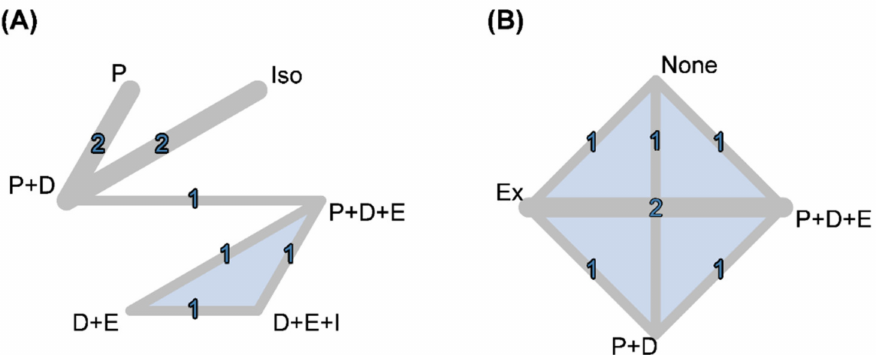
Figure 2. Network graphs of ( A ) main functional outcome (changes in hand grip) and ( B ) main body compositional outcome (muscle mass). D, vitamin D; E/Ex, exercise; Iso, iso-caloric product; P,